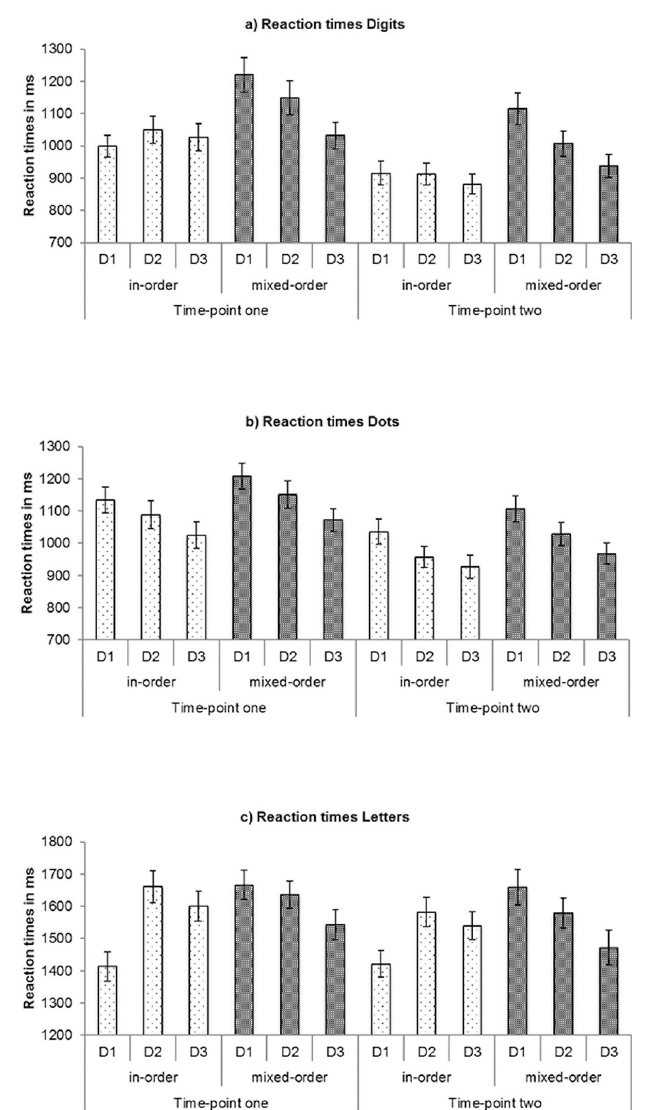
Figure 2. Bar graphs depicting reaction times of a) symbolic numbers, b) non-symbolic numbers, and c) letters of the alphabet as a function of Time point (T1 and T2), Order, and Distance (D1 = Distance 1; D2 = Distance 2; D3 = Distance